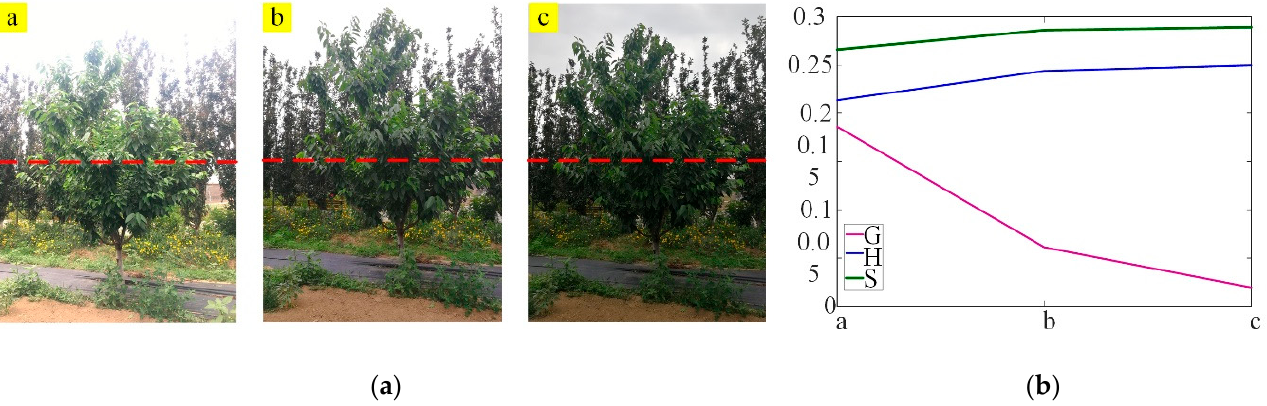
Figure 5. Influence of lighting conditions on spectral components: ( a ) an image of a fruit tree with fading light from left to right and ( b ) the curve of green, hue and saturation under different lighting conditions.